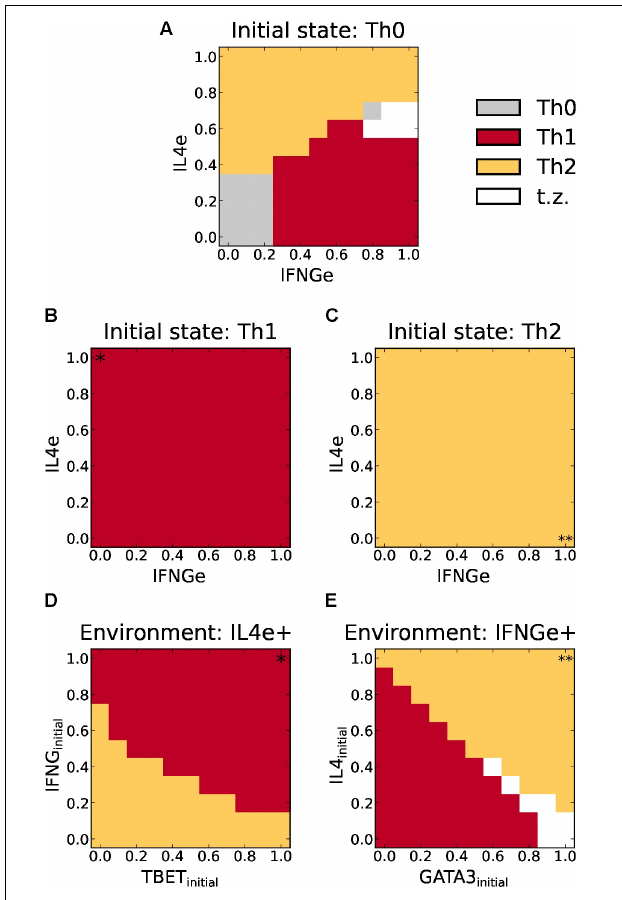
FIGURE 5 | Phenotype space diagrams for Th1 and Th2 polarization and plasticity as a function of the relative concentration of environmental IFNg and IL4, and expression of transcription factors. (A) Diagram for cell differentiation assuming an initial Th0 state. As the external concentration of IFNGe increases, the system develops an abrupt transition from Th0 to Th1. Similarly, an increase in external IL4e drives an abrupt transition from TH0 to Th2. For moderate concentrations of IFNGe and IL4e ( < 0.8), we observe two wide zones of Th1 or Th2 prevalence with a sharp boundary, meaning that small variation of cytokines at these zones may change cell polarization. A transition zone with no defined polarization appears at higher concentrations of these cytokines (white and gray areas). (B,C) Plasticity diagrams assuming full Th1 (B) or Th2 (C) polarized states (i.e., induced by INFg = 1 and IL-4 = 1 in diagram A , respectively). No phenotypic transitions are observed under variable concentrations of environmental IL4e and autocrine IFNGe. (D) Plasticity diagram of Th1 cells assuming an environmental concentration of IL4e = 1. Cells require the production of initial high levels of autocrine IFNG and expression of TBET to maintain a Th1 phenotype. If the initial expression levels decrease, especially in the case of autocrine IFNG, it will transit into a Th2 cell. (E) Plasticity diagram of Th2 cells assuming an environmental concentration of IFNGe = 1. The cell requires the production of high levels of autocrine IL4 and expression of GATA3 to maintain a Th2 phenotype. If the initial expression levels decrease it will transit into a Th1 cell. At high expression levels of initial GATA3 and low initial IL4, there exists a transition zone where the cell cannot be